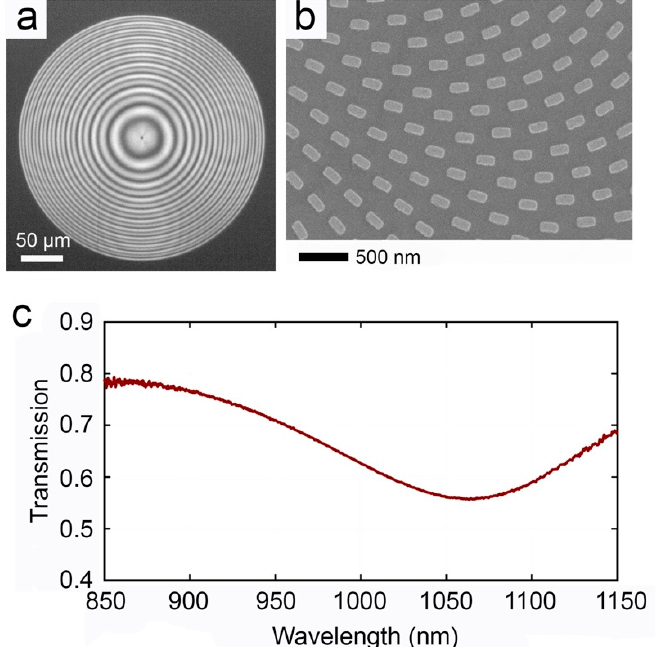
Figure 2. The schematic of plasmonic metalens designed for the focal length of 800 µ m. ( a ) Optical microscopy image of the metalens surface. The scale bar is 50 µ m, ( b ) SEM image of part of the lens showing the gold nanorods. The scale bar is 500 nm. ( c ) Measurement of the FTIR transmission spectra of the metalens showing localized surface plasmon polariton resonance at 1064